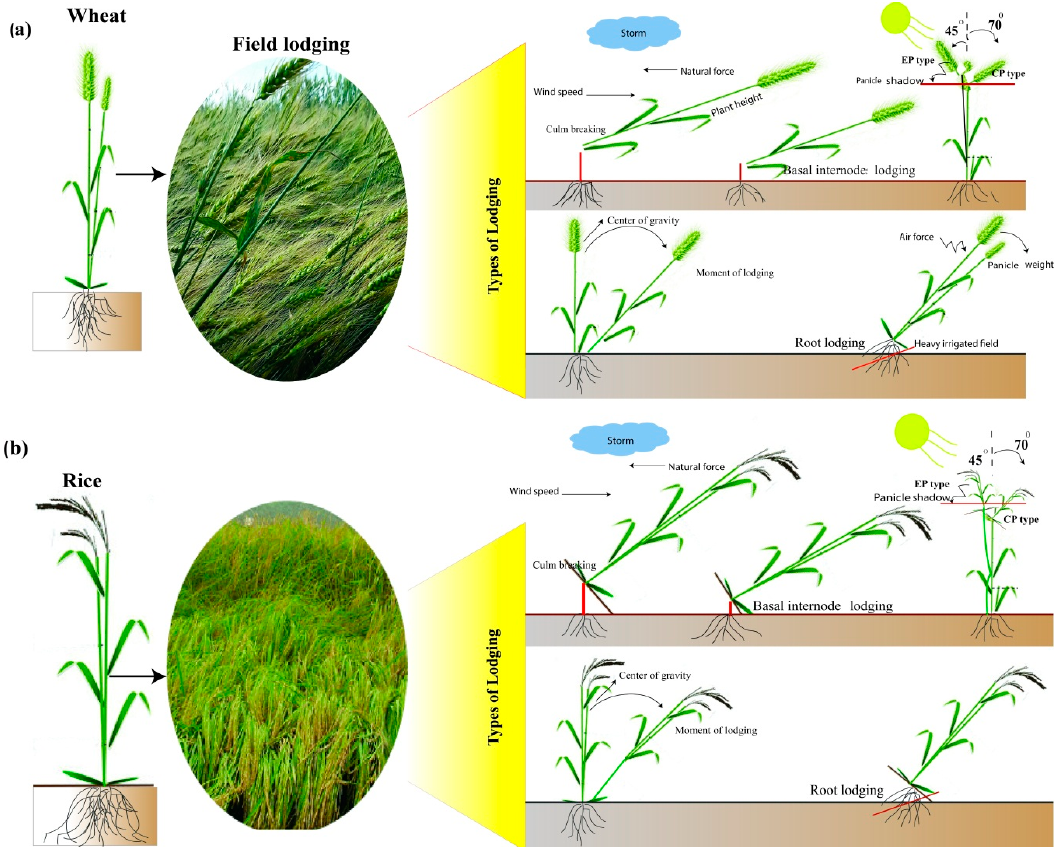
Figure 2. Various types of lodging that are devastatingly reducing yield in ( a ) wheat, ( b ) rice: diagrammatically presented as follow: culm breaking; basal internode lodging; panicle shadow on a leaf during sunlight and the force of the panicle on the stem between erect (EP) and curve panicle (CP) plants; lowers the center of gravity due to decrease in plant height and increases bending type lodging resistance, and root lodging.